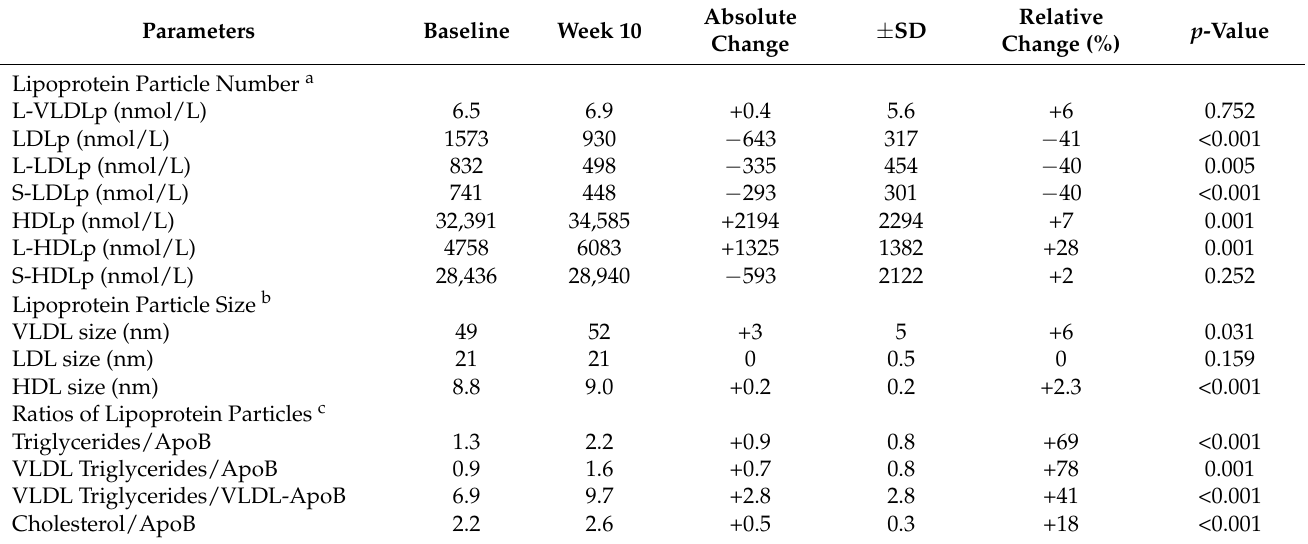
Table 3. Effects of alirocumab on lipoprotein particle numbers, ratios of particle subfractions, and lipoprotein lipase